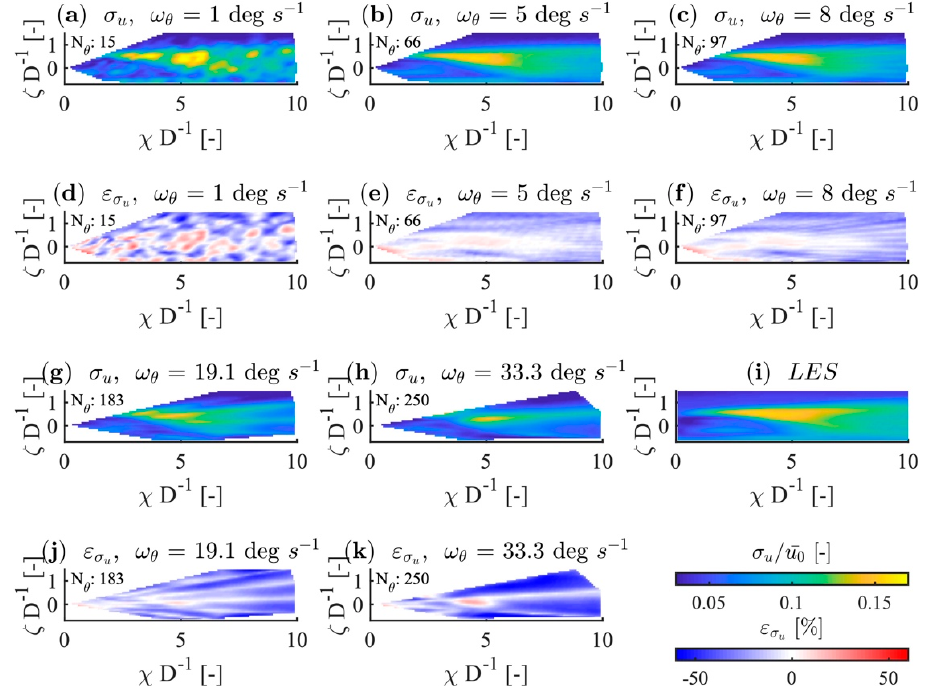
Figure A2. Visualisation of the normalised 10-min standard deviation, σ u , of the wind-speed component, u , of the original RHI data and ( d – f ) and ( j – k ) the corresponding deviations, ε σ ( i ) the normalised 10-min standard deviation of wind-speed component, 𝑢 , of LES data.